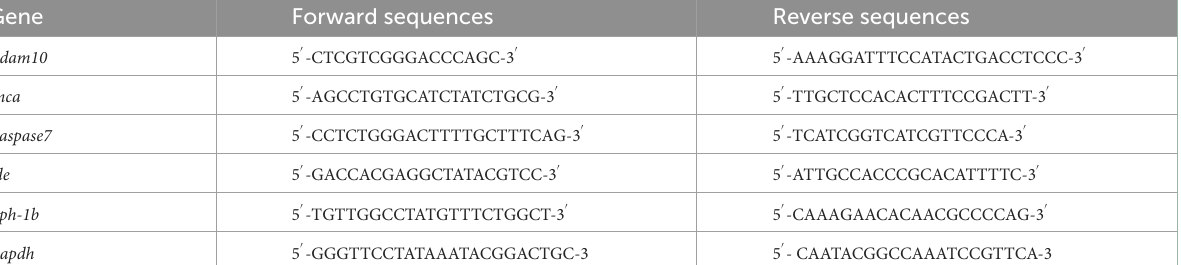
TABLE 2 Primers used in this study. Gene Forward sequences Reverse